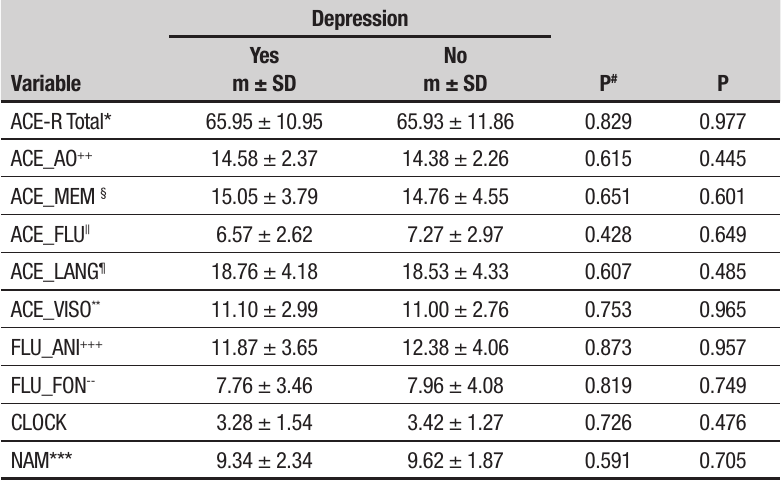
Table 2. Median and standard deviation results on the ACE-R and its domains according to pres- ence of Current Major Depressive Episode in 116 elders treated at the reference clinic of a mental health program under the Family Health Strategy of Porto Alegre-RS, Brazil.